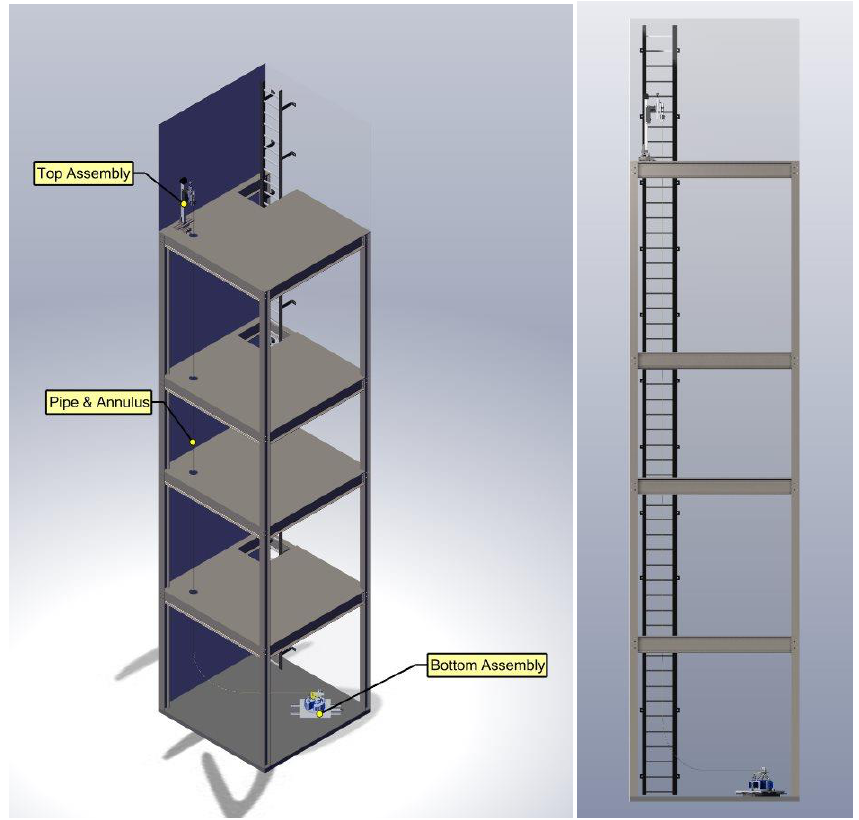
Figure 2. Experimental layout at the drilling vibration lab, University of Oklahoma.